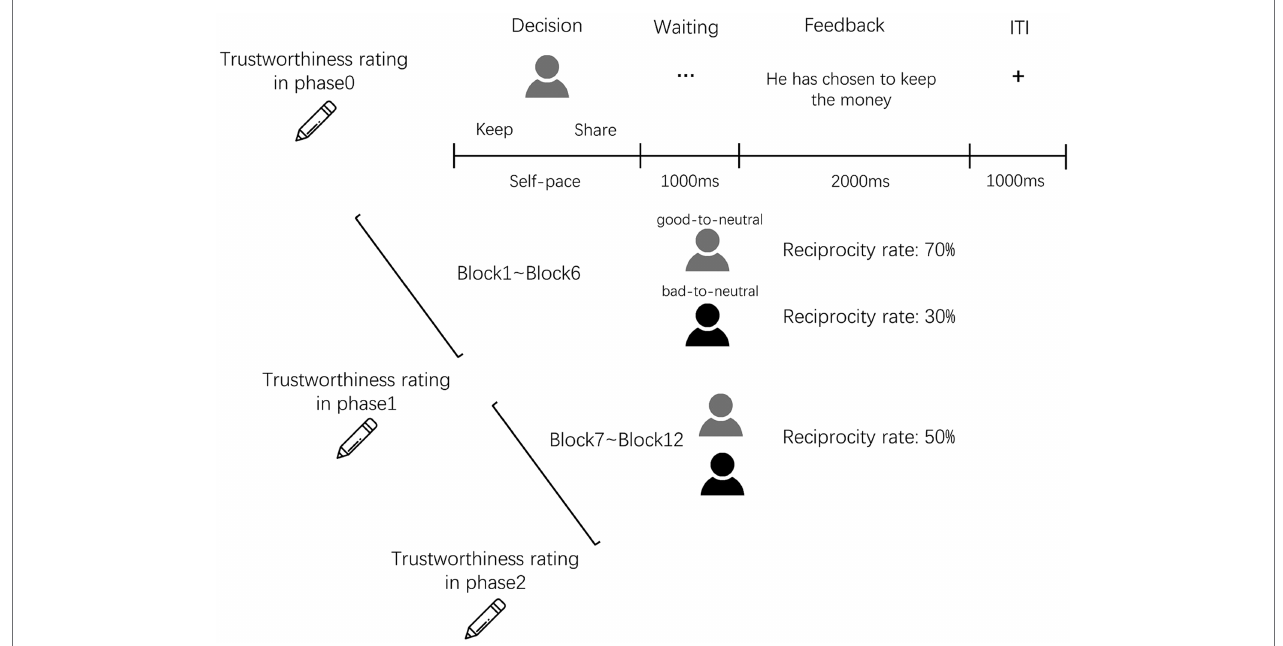
FIGURE 1 | Experiment schematic. Participants completed a two-phase trust game interspersed with three trustworthiness ratings (i.e., phase0: before the trust game, phase1: at the end of Block6, phase2: at the end of Block12). Participants as trustors interacted with two trustees. The good-to-neutral trustee yielded a higher initial return rate (70%) while the bad-to-neutral trustee yielded a lower initial return rate (30%) in Block1 to 6. In Block7 to 12, these two trustees changed their return rates both to neutral